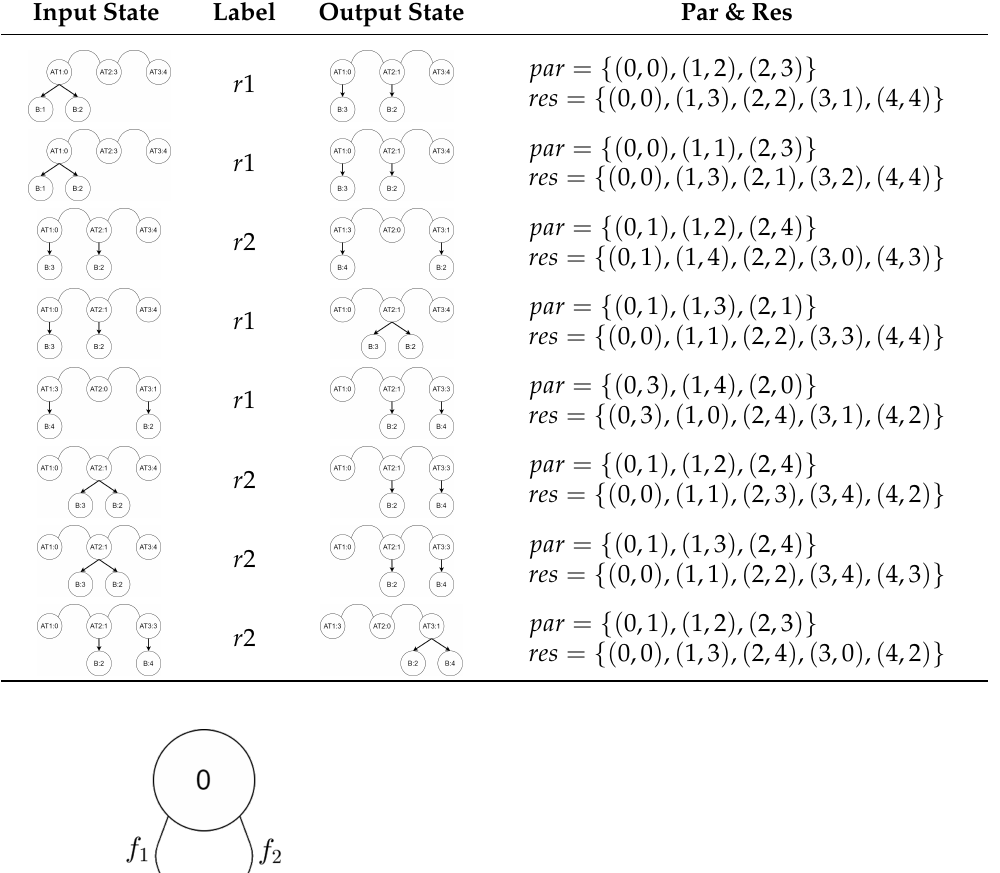
Table 17. Tracking Transition System for the second example.